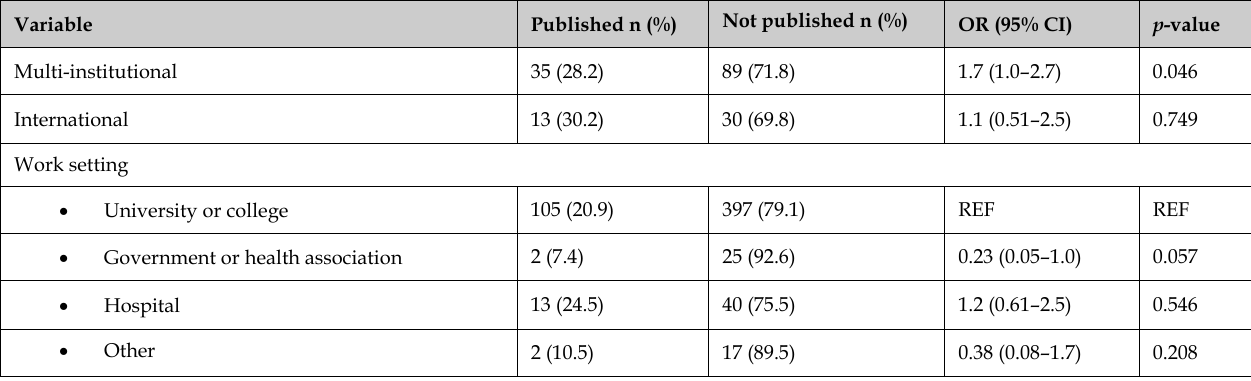
Table 4 Potential variables associated with publication: setting or